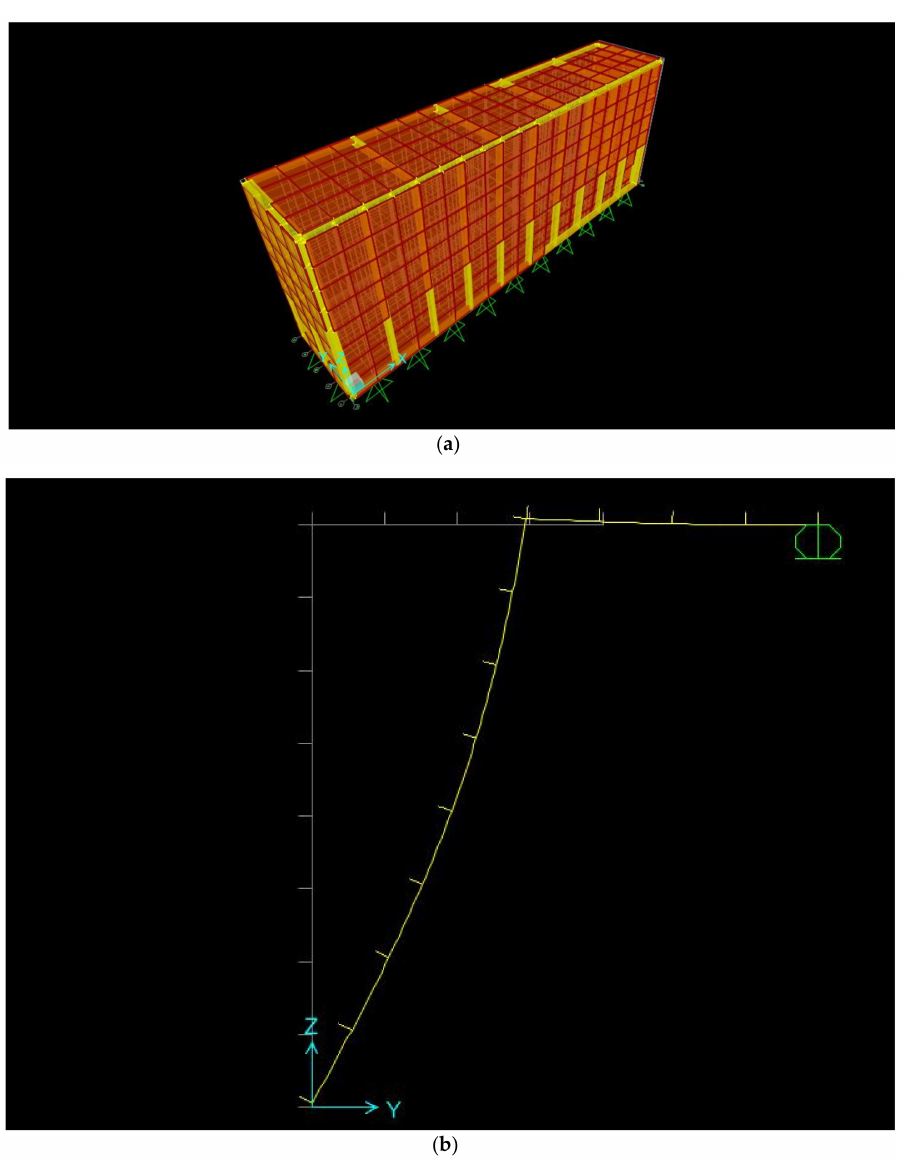
Figure 23. FEM model: ( a ) SAP 2000 FEM model of the experimental specimen; ( b ) Deformation on the central profile PE of the FEM